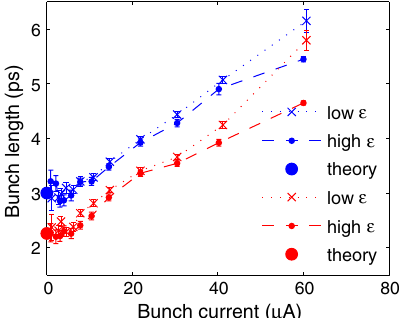
FIG. 5. Comparison between bunch length measurements for the high- and low-emittance lattices at (cid:3) 1 ¼ (cid:1) 6 (cid:5) 10 (cid:1) 6 . The cavity voltage was varied between 1.5 MV (blue) and 2.2 MV (red). The theoretical natural (zero-current) bunch lengths given by Eq. (13) are marked as